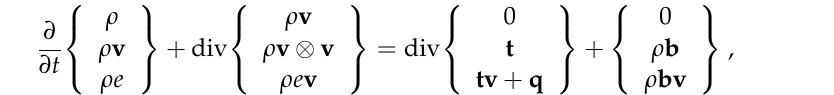
Figure 2. Laser assisted separation of adhesions in nasal septum. ( a ) ( b )